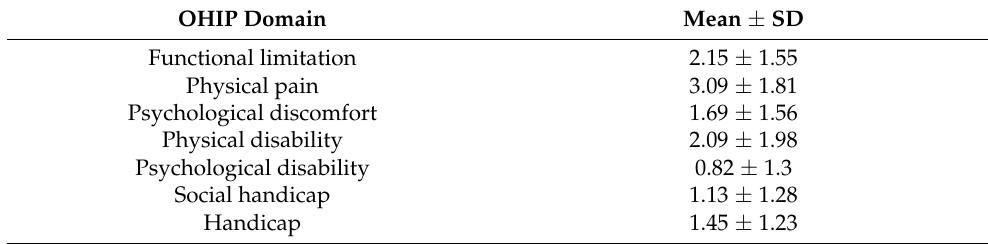
Table 5. Average OHIP-14 domain scores in all the patients included in the study.